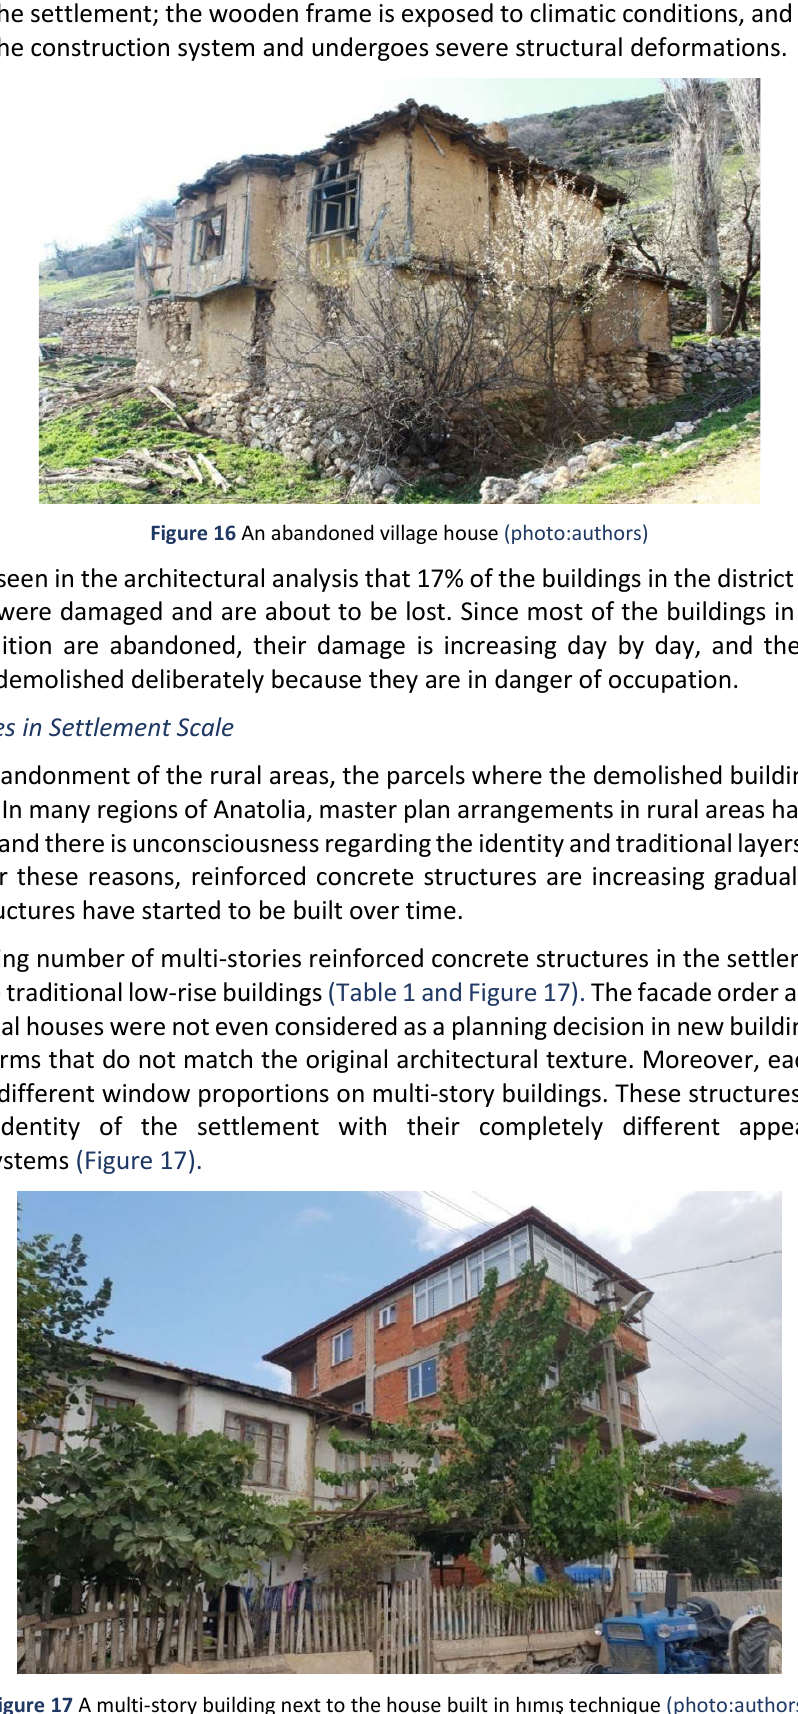
Figure 17 A multi-story build ing next to the house built in hımış technique